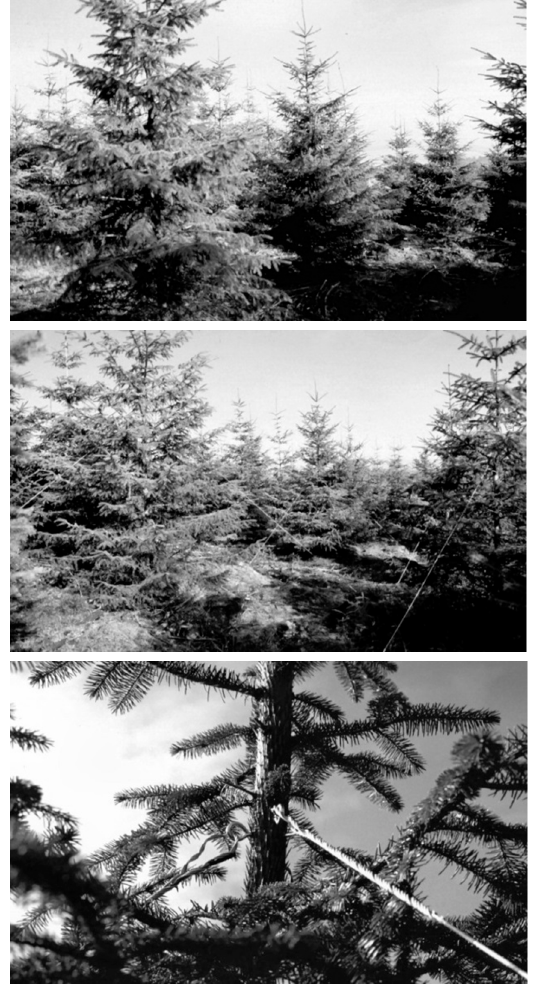
Figure 1. The experimental site and treatments. From top: “Thinned” treatment; “Thinned and Guyed” treatment; Cables attached to a guyed tree.